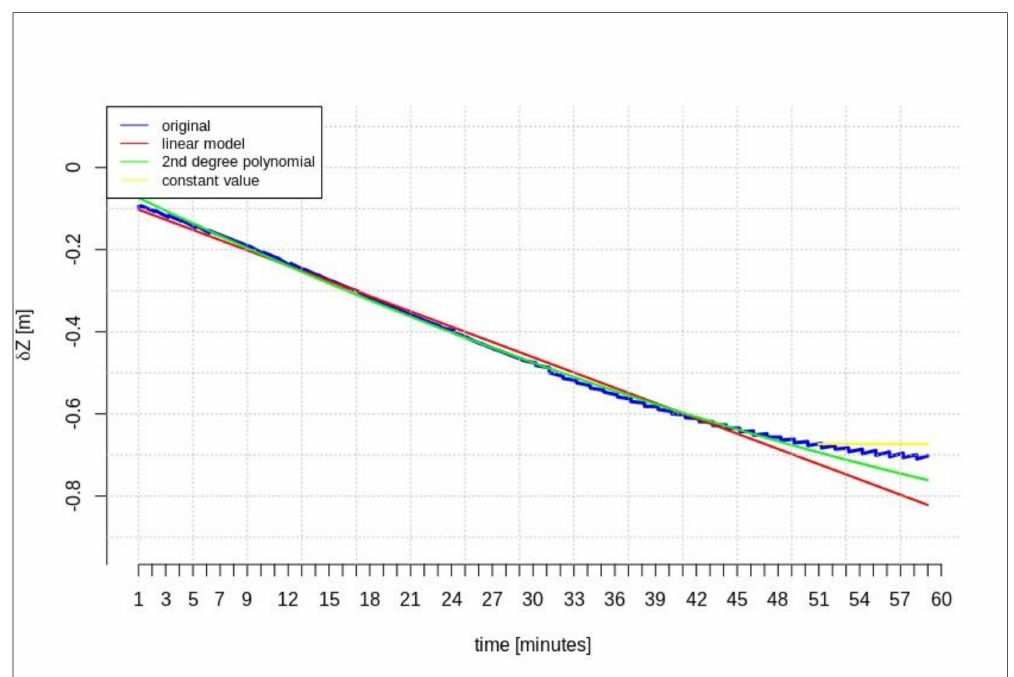
Figure 13. The results of the δ Z geocentric correction extrapolation (GPS G28) for a 60-min data-stream between each